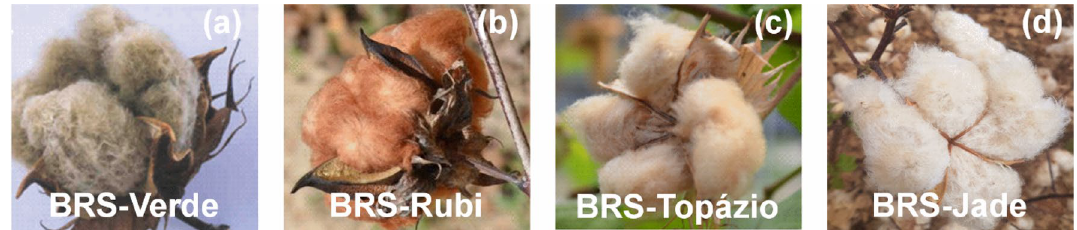
Figure 1. Cultivars BRS-Verde ( a ), BRS-Rubi ( b ), BRS-Topázio ( c ), BRS-Jade ( d